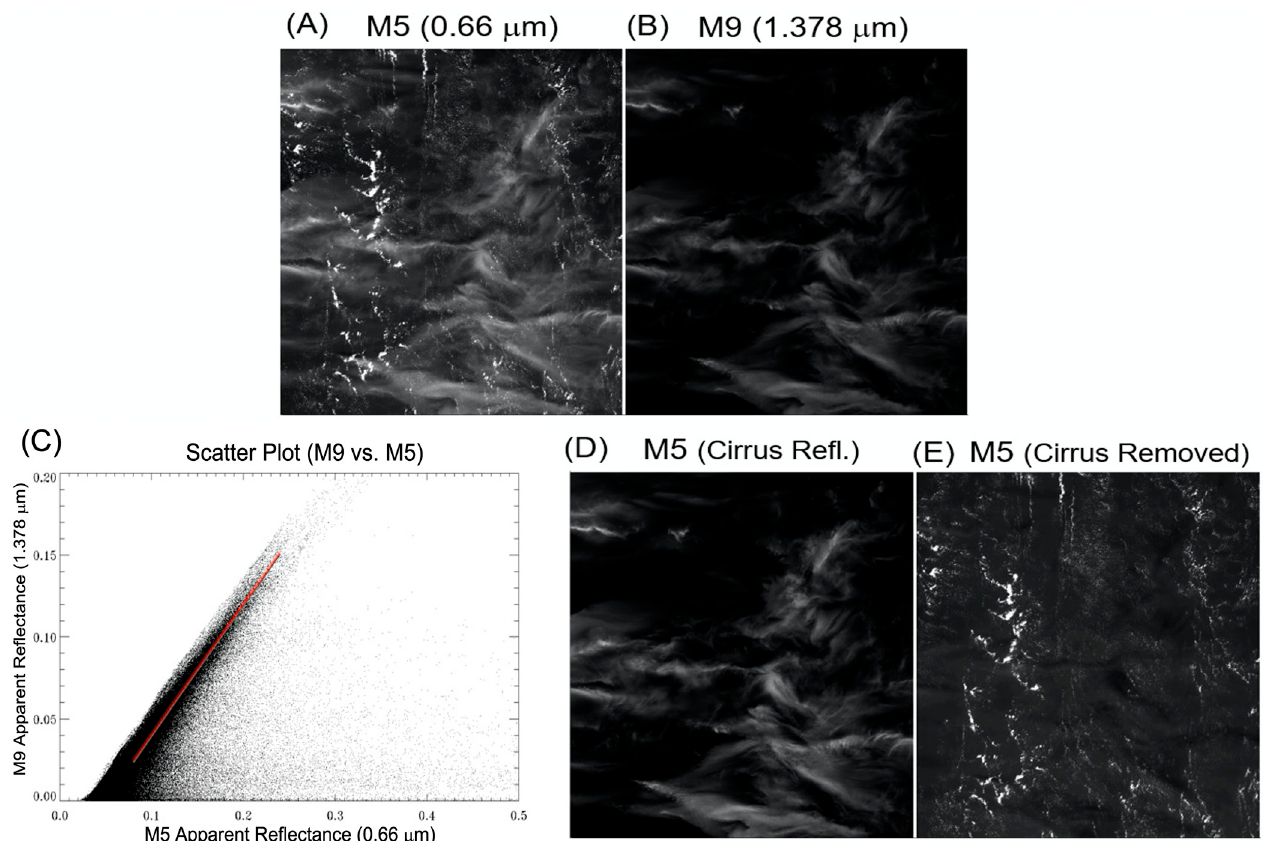
Figure 4. A portion of a VIIRS M5 band apparent reflectance image ( A ), the M9 band apparent reflectance image ( B ), the scatter plot of M9 versus M5 band images ( C ), the derived M5 band cirrus reflectance image ( D ), and the cirrus-removed M5 band apparent reflectance image ( E ) [20].